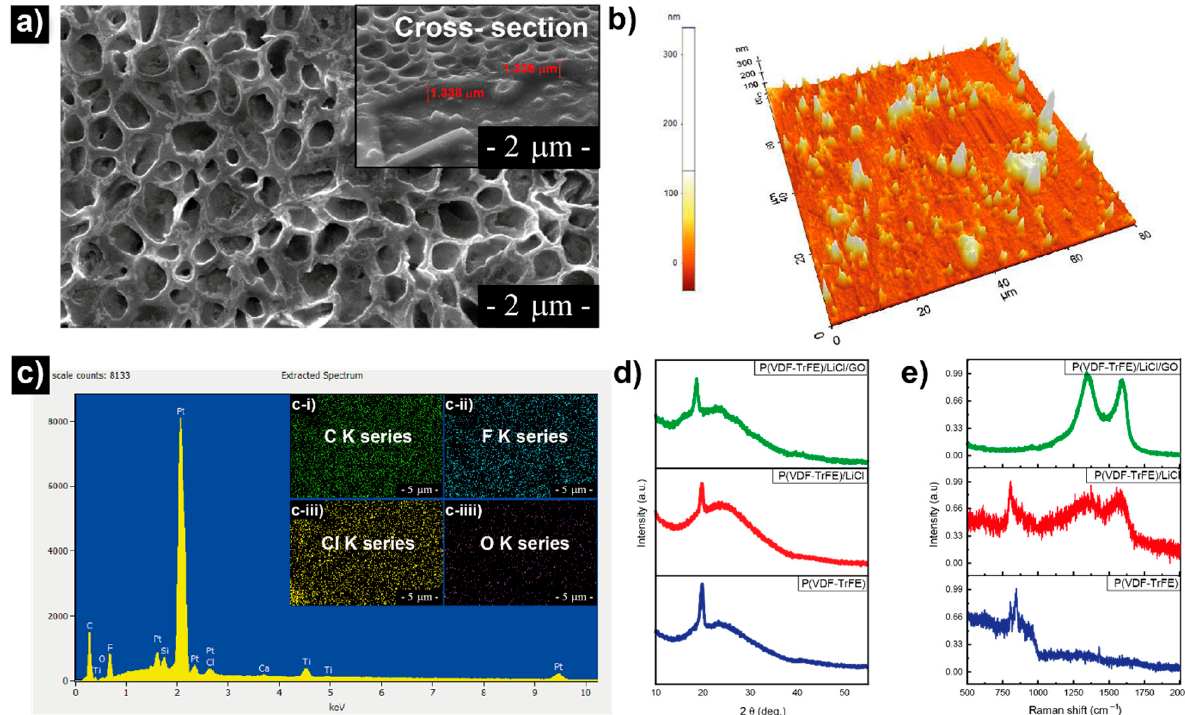
Figure 2. Characterization of the GO-doped P(VDF-TrFE)/LiCl composite based humidity sensor. ( a ) SEM images of the GO-doped P(VDF-TrFE)/LiCl, ( b ) the AFM image composites, ( c ) SEM-EDS analysis and elemental mapping, ( d ) XRD, and ( e ) Raman spectroscopy results of pure P(VDF-TrFE), P(VDF-TrFE)/LiCl, and GO-doped P(VDF-TrFE)/LiCl composites.